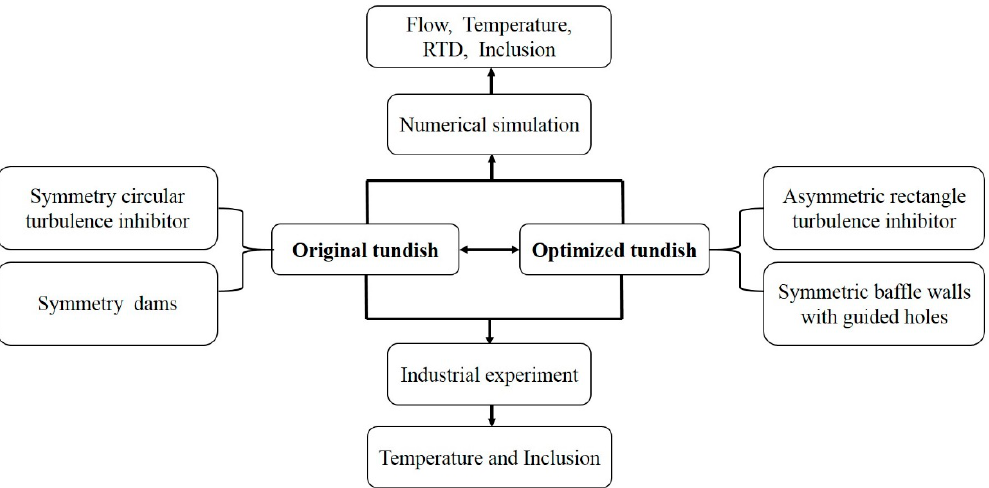
Figure 1. Optimize the physical field for an asymmetric tundish.